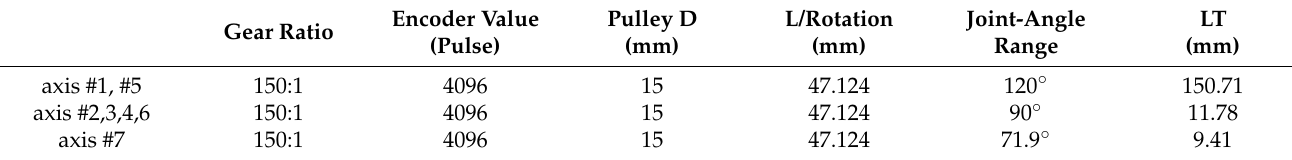
Table 1. Relationship between the length and the angle.